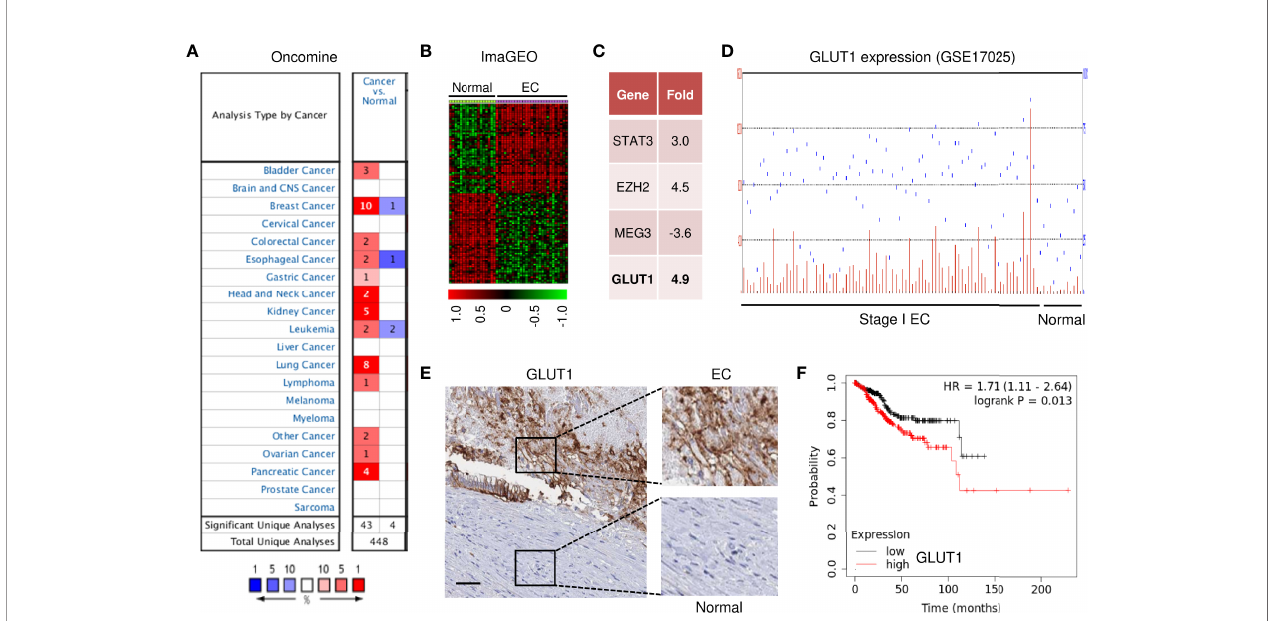
FIGURE 1 | GLUT1 Expression and Clinical Importance in EC. (A) The mRNA expression of GLUT1 (cancer versus normal tissues) in pan-cancers was analyzed with the Oncomine database. The graphic demonstrates the number of datasets that meet our threshold for each cancer type. Red: up-regulation; blue: down- regulation. (B) The heatmap was generated by the ImaGEO database using two EC data sets (GSE17025 and GSE56026). (C) Up- or down-regulated genes in EC tissues compared to normal tissues (ImaGEO). (D) The GEO dataset was analyzed for GLUT1 expression in stage I EC samples and normal endometrium samples. (E) The expression of GLUT1 protein was examined in EC tissue and adjacent normal tissues (Human Protein Atlas database; scale bar: 100 m m). (F) The probability of overall survival in EC patients expressing high or low GLUT1 levels was assessed using the KM plotter